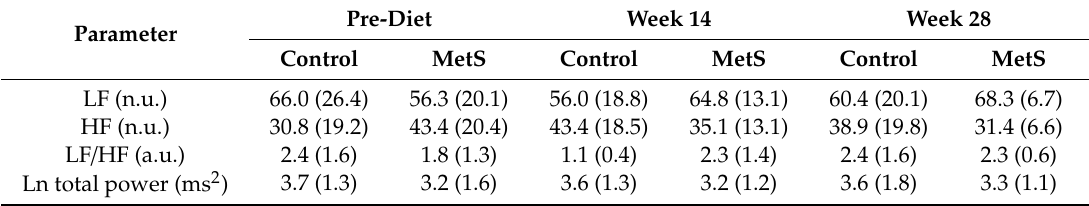
Table 2. Frequency-domain parameters of short-term HRV analysis.